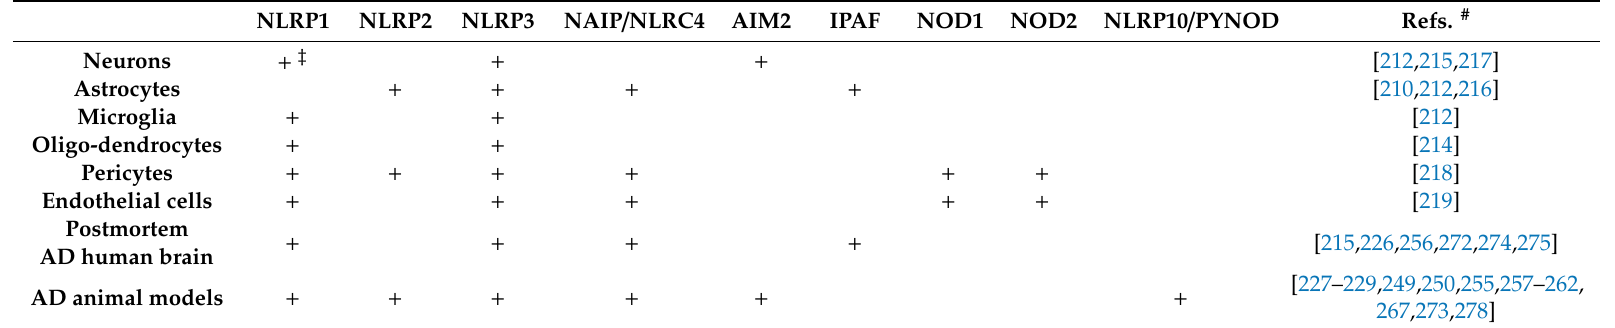
Table 3. The main inflammasomes expressed in human CNS cell types, in human AD brains and in AD-model animal brains.